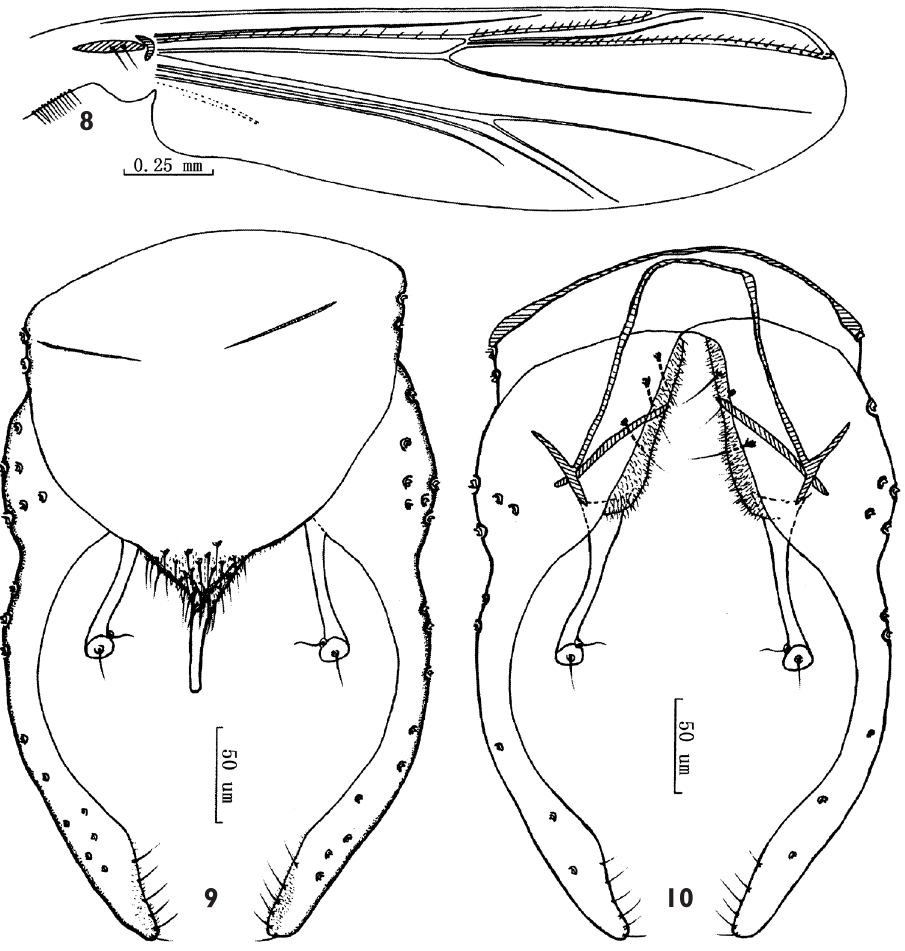
Figures 8–10. Parachironomus monochromus (van der Wulp), Chinese specimens. 8 Wing 9 Dorsal view of hypopygium 10 Ventral view of length/wing length 1.80–1.98, 1.88 (8). Wing length/length of profemur 2.28–2.57, 2.48 (8). Coloration . Thorax yellowish green to dark brown. Front legs with femora yellow- ish green to dark brown, tibiae and tarsi dark brown except for tarsi I yellowish green in basal 4/5; mid and hind legs yellowish green to yellowish brown except for tarsi V dark brown. Abdomen yellowish green to dark brown. Head . AR 1.86–2.27, 2.12. Terminal flagellomere 540–720, 673 µm long. Frontal tubercles absent (7) or present (2), cone-shaped, 15–22 µm high, 12–22 µm wide at